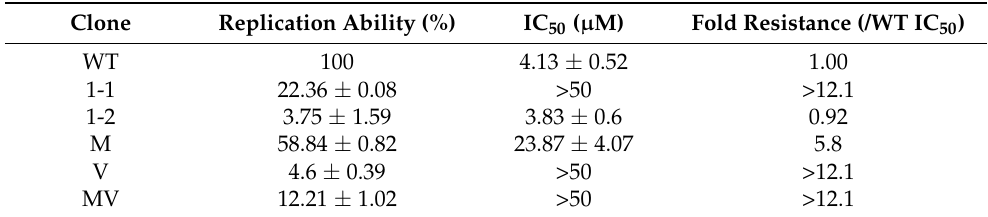
Table 4. Replication ability and IC 50 values of mutant clones against BFV in Huh7 cells. Clone Replication Ability (%) IC 50 ( µ